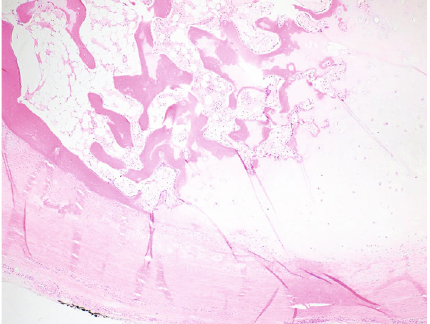
Figure 10: Pathology consistent with osteochondroma with cartilage cap (magni fi cation × 40). The sessile lesion shows an intact smooth cartilaginous cap overlying bony trabeculae. The perichondrium that overlies the chondrocytes is continuous with the periosteum. The medullary cavity contains predominantly fat and fi brous tissue with minimal trilineage hematopoiesis. There are focal areas of the reactive bone with new bone